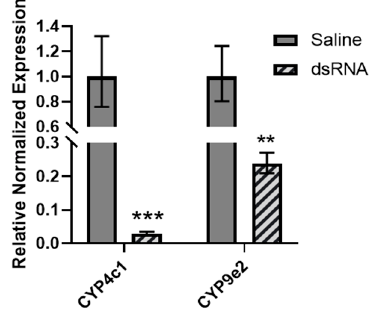
Figure 5. RNAi-based downregulation of CYP4c1 and CYP9e2 in saline- and dsRNA-injected L. decemlineata . Histogram presents expression levels of targets of interest in dsRNA-injected insects seven days following injection quantified by qRT-PCR. Controls used were insects injected with saline solution. Results shown are standardized transcript levels (mean ± SEM, n = 4). Asterisks present results that are significantly different (** p < 0.01, *** p < 0.001).